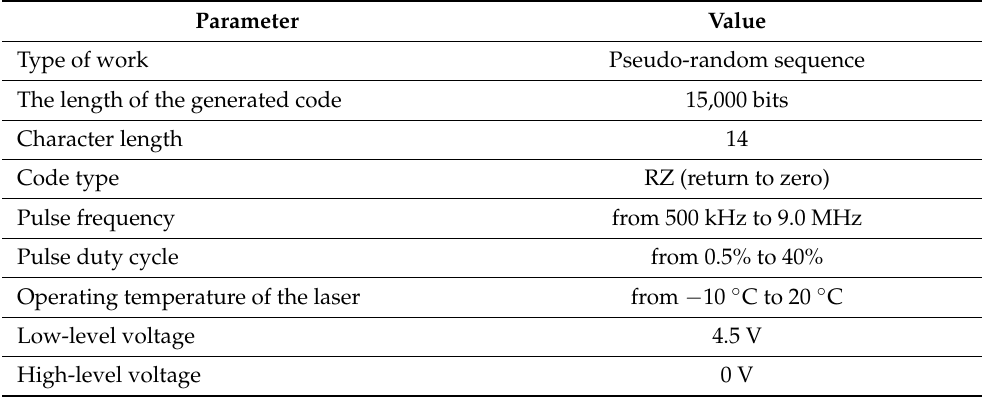
Table 2. Parameters of the pulses generated by the Picosecond 12,000 generator, for which the BER studies were